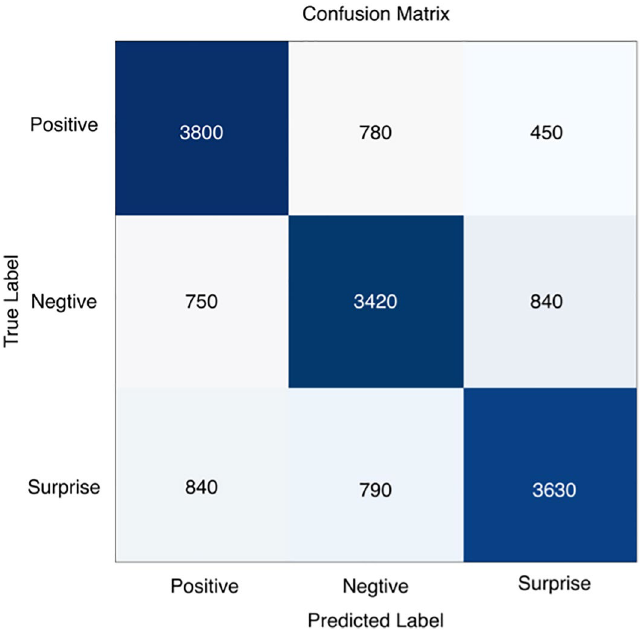
Figure 11. ShuffleNetV2 with improved ViT is pre-trained and the classifier uses SVM.